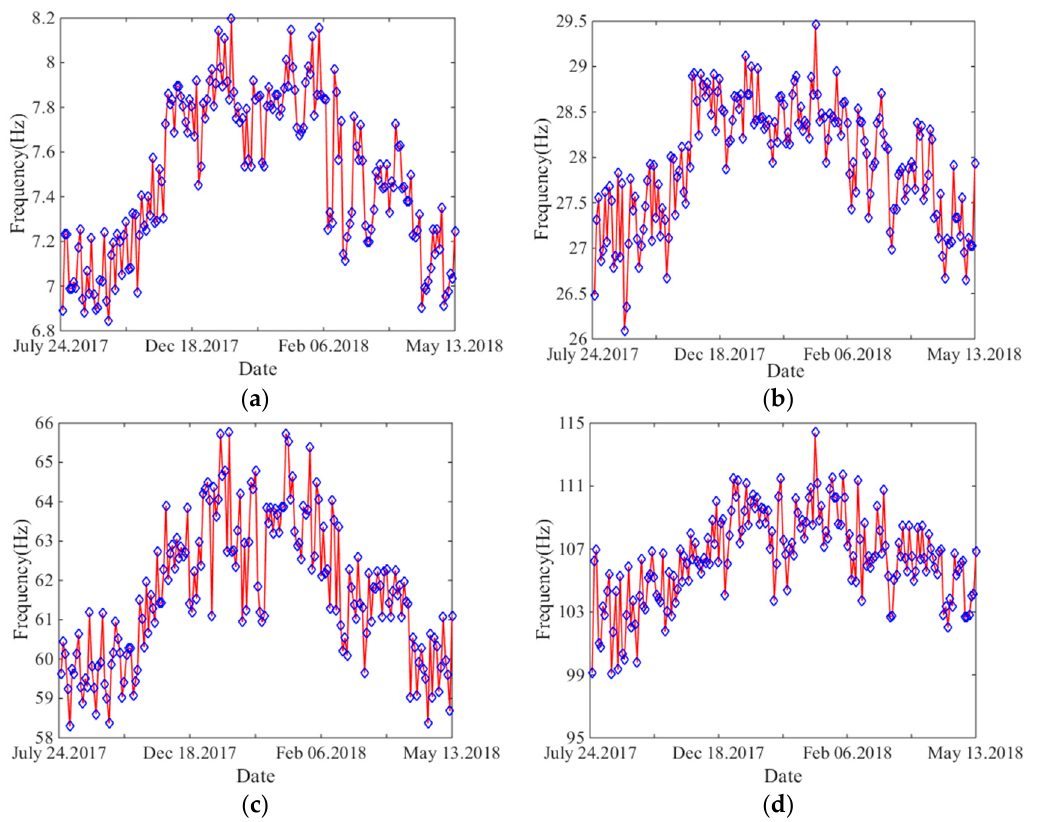
Figure 7. Frequencies vs. test date. ( a ) 1st mode. ( b ) 2nd mode. ( c ) 3rd mode. ( d ) 4th mode. Table 1. The maximum and minimum natural